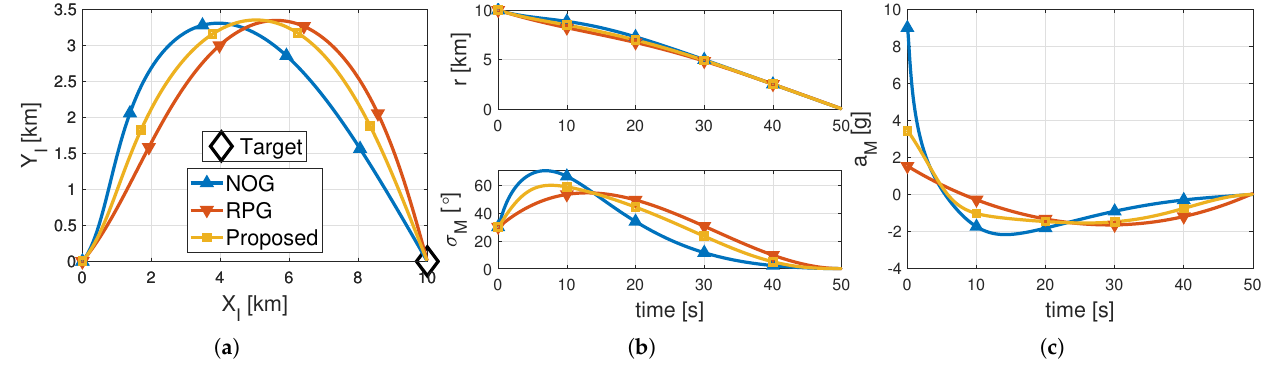
Figure 4. Simulation results under NOG, RPG, and the proposed law for the desired constraint of t d = 50s. ( a ) Flight trajectories; ( b ) state variables; ( c ) guidance